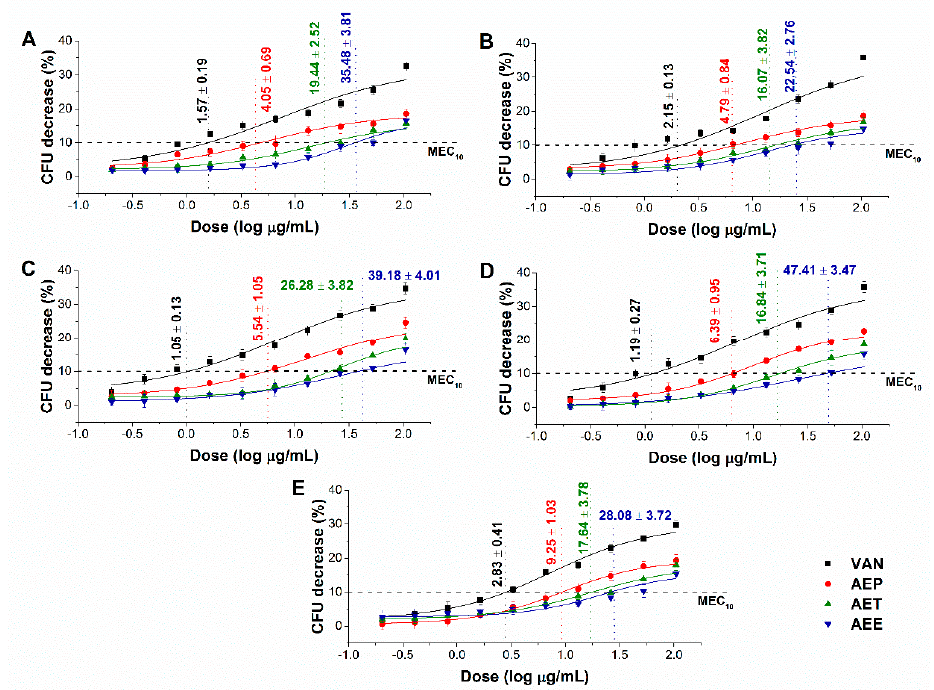
Figure 5. Minimum effective concentration (MEC 10 ) of AEP, AET and AEE (µg/mL) on E. coli ( A ), S. aureus ( B ), B. subtilis ( C ), P. aeruginosa ( D ), and S. pyogenes ( E ). Six independent experiments, each with three technical replicates, compared to vancomycin (VAN) were considered (mean ± SD).